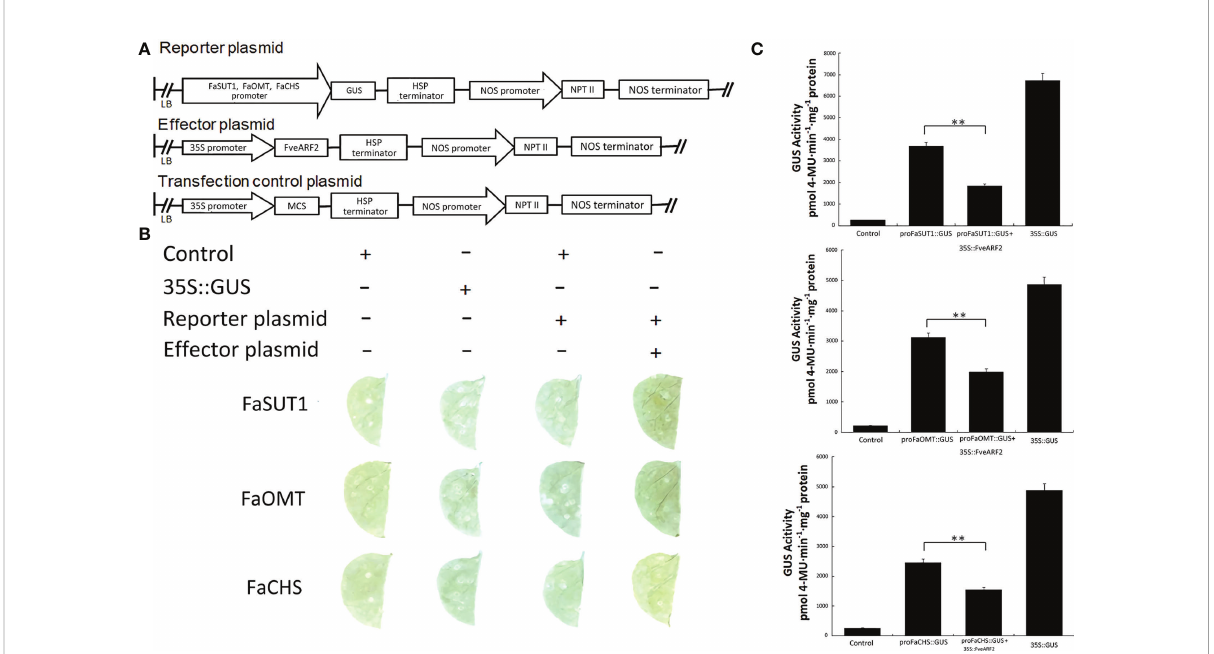
FIGURE 8 FveARF2 negatively regulates the expression of FaSUT1, FaOMT, and FaCHS by binding to their promoters. (A) Structural diagram of the reporter, effector, and transfection control plasmids. (B, C) GUS activity indicates an interaction between FveARF2 and the FaSUT1 , FaOMT , and FaCHS promoters. The pRI201-AN and 35S::GUS vectors were used as negative and positive controls, respectively. In vivo GUS activity analysis showing that FveARF2 negatively regulates FaSUT1 , FaOMT , and FaCHS expression. Values are the mean ± SD from three independent experiments with three biological replicates. ‘ ** ’ Indicates very signi fi cant differences (P < 0.01, Duncan ’ s multiple range test).